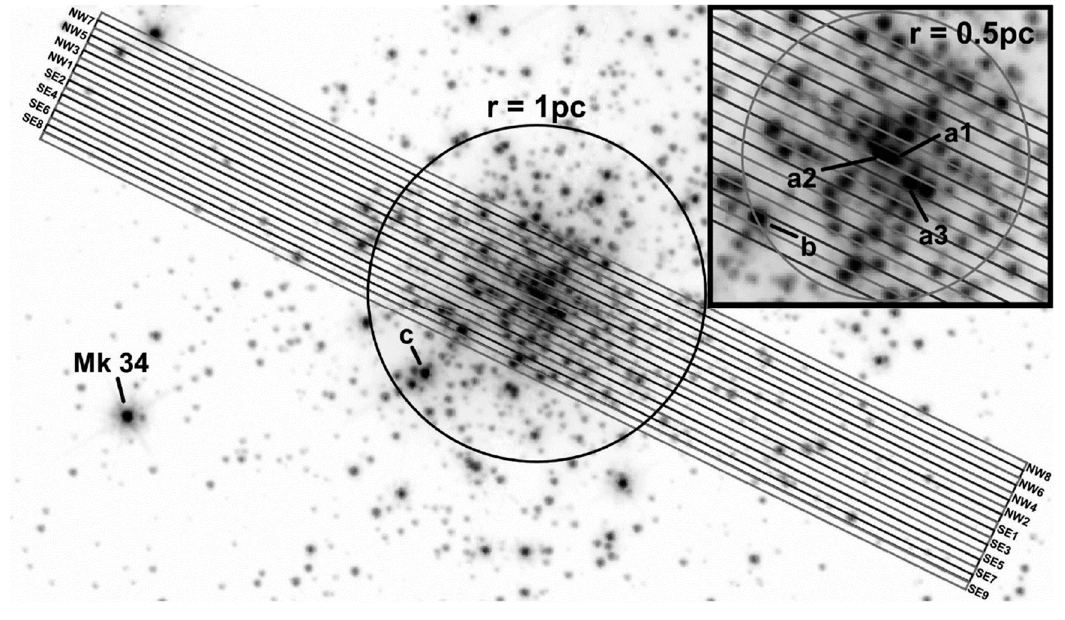
Figure 4. HST / STIS 52” × 0.2” apertures overlaid on an HST image of R136. The central region is shown Figure 4. HST/STIS 52 ʺ × 0.2 ʺ apertures overlaid on an HST image of R136. The central region is shown in the insert at the top right, which has a radius of 2.05”, corresponding to 0.5 parsec at the distance of in the insert at the top right, which has a radius of 2.05 ʺ , corresponding to 0.5 parsec at the distance the LMC. From of the LMC. From [15].